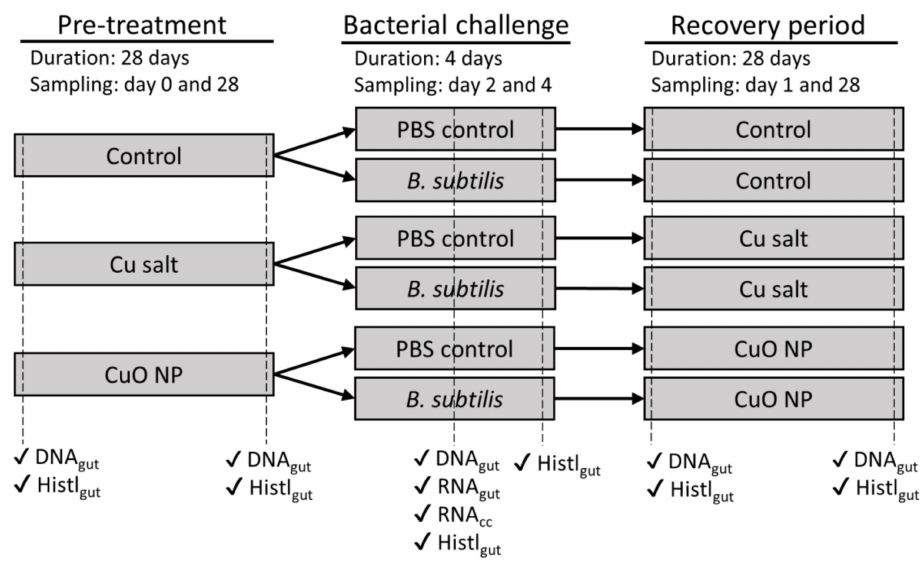
Figure 1. Schematic overview of the study design and collected samples. Dashed lines indicates sampling points. Tick marks indicate the samples collected at the respective sampling point. ‘DNA gut ’ indicates sampling of DNA from gut tissue for microbiome analysis; ‘RNA gut ’ and ‘RNA cc ’ indicate sampling of RNA for gene expression analysis from gut tissue and coelomic fluid, respectively; and ‘Histl gut ’ indicates sampling of gut tissue for histological analysis. NP, nanoparticle; PBS, phosphate bu ff ered